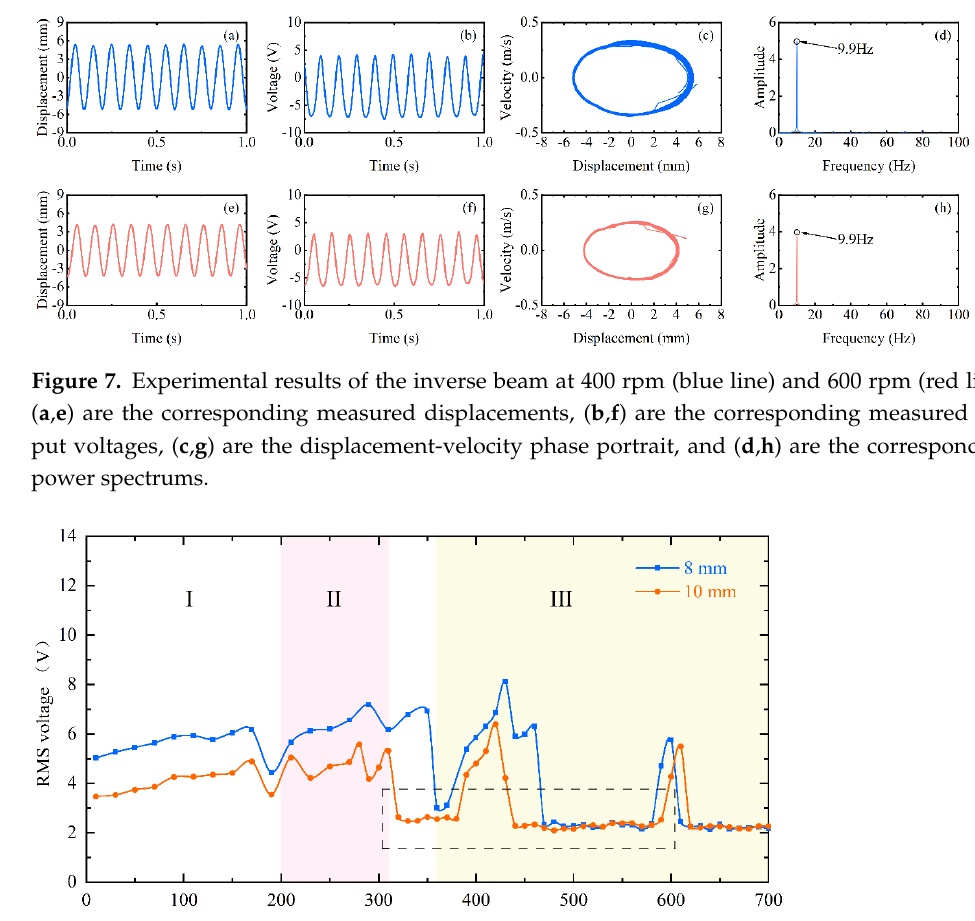
9 of 17 Figure 6. Experimental results of the inverse beam at 270 rpm (blue line) and 330 rpm (red line), ( a , e ) are the corresponding measured displacements, ( b , f ) are the corresponding measured output voltages, ( c , g ) are the displacement-velocity phase portrait, and ( d , h ) are the corresponding power